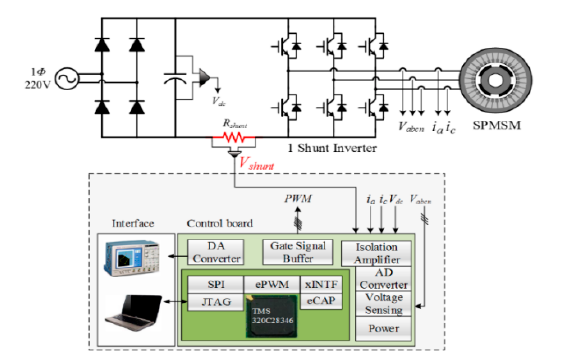
Figure 11. Configuration of the hardware system.